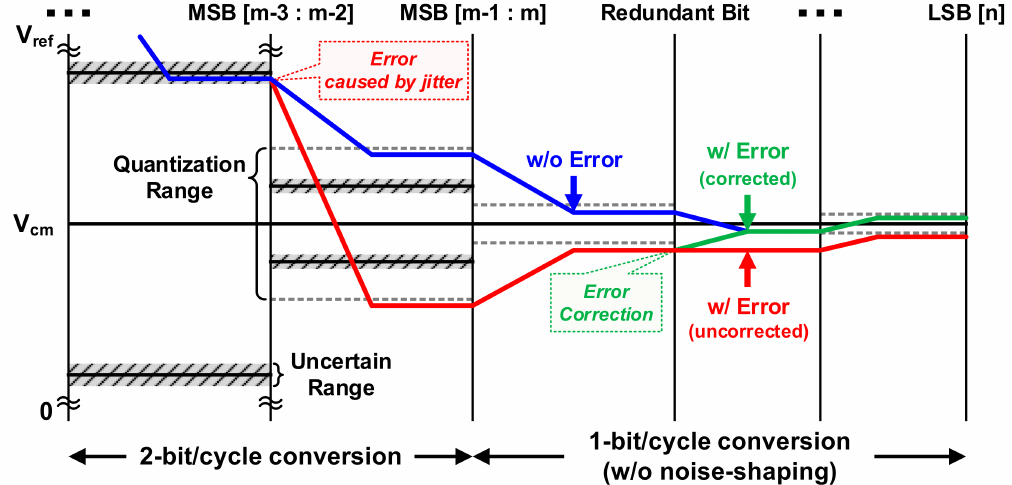
Figure 4. Conversion process for m-bit MSBs and n-bit LSBs and jitter error correction with